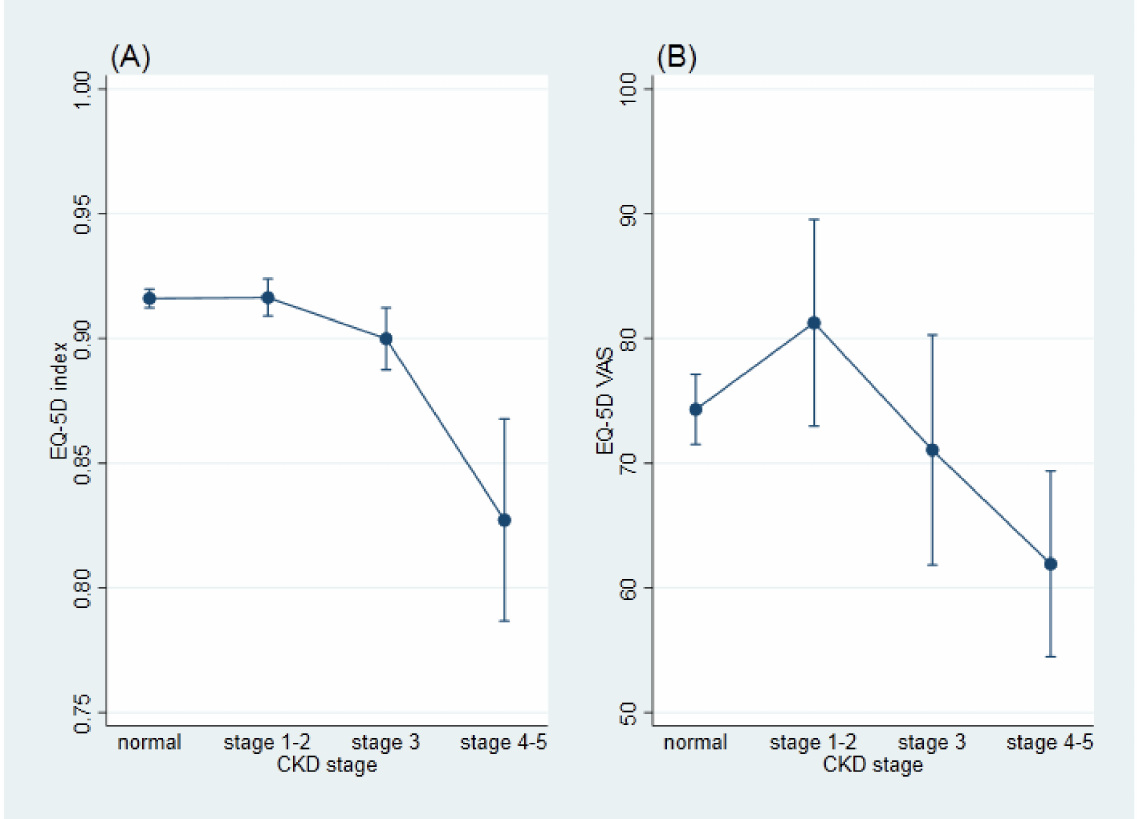
Figure 2. The adjusted EQ-5D index ( A ) and EQ-VAS ( B ) by CKD stage. The adjusted EQ-5D and EQ-VAS were estimated across CKD stage using a linear regression applying complex survey weights. The models were adjusted for age, sex, body mass index, residential area, education level, income, smoking, alcohol drinking, physical activity, and presence of chronic diseases, including hypertension, stroke, coronary heart disease, asthma, chronic obstructive pulmonary disease, arthritis, non-alcoholic fatty liver disease, and a history of